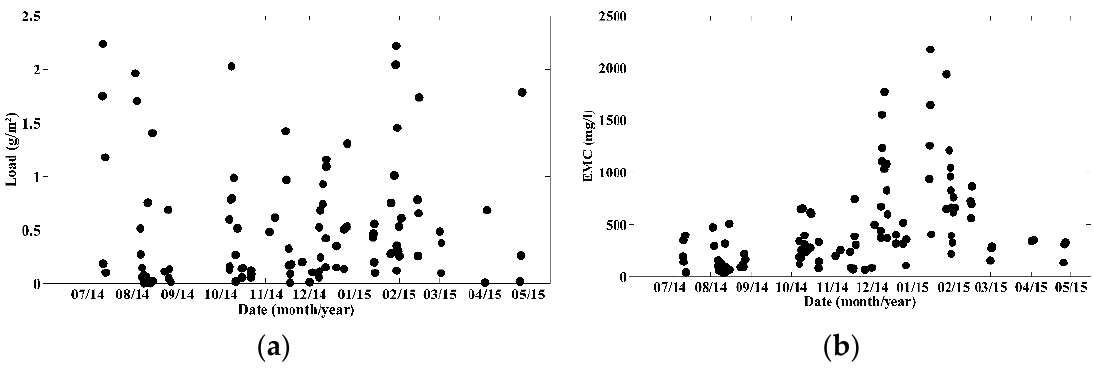
Figure 3. ( a ) Temporal variation of EMC (mg/L) for TSS from June 2014 to April 2015; and ( b ) temporal variation of load (g/m 2 ) for TSS from June 2014 to April 2015. Table 6. Seasonal values of average EMC (mg/L) and total yields(g/m 2 ) and min-max values of maximum rainfall intensity (mm/h) and rainfall depth (mm) and total rainfall depth of storm events for each season.